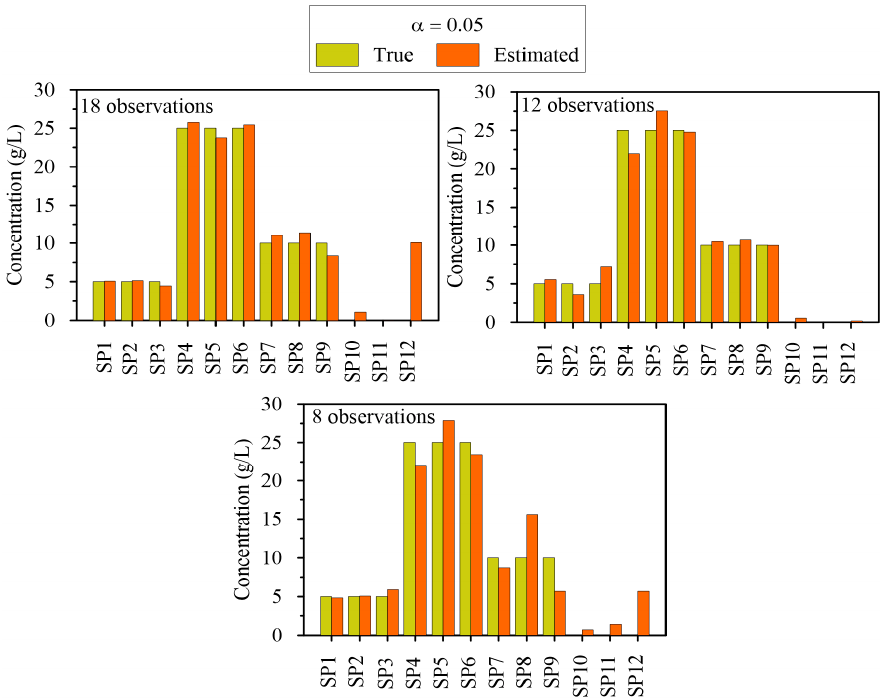
Figure 15. Source release histories in error-perturbed data condition ( α = 0.05) concentration with 18, 12 and 8 observed concentrations data.